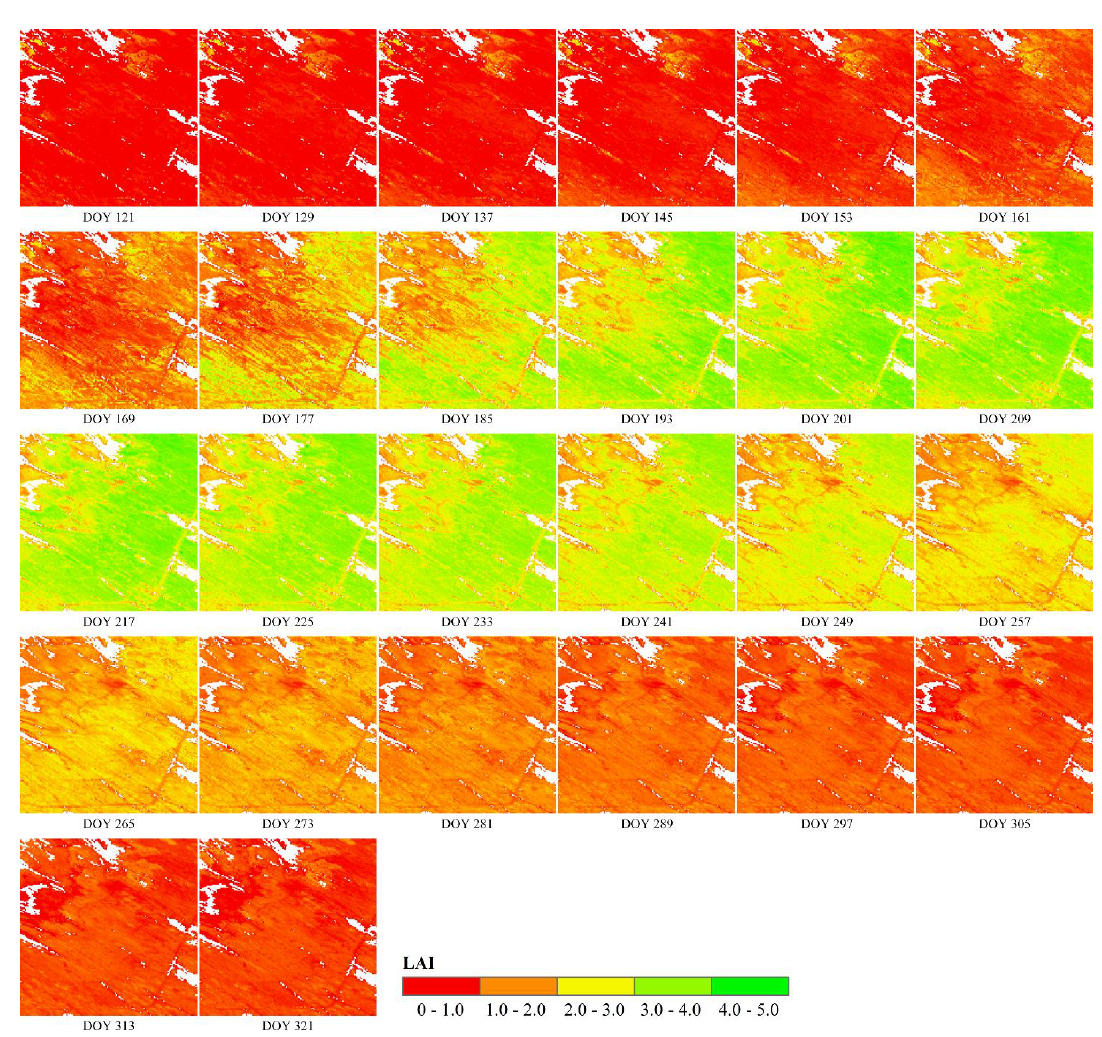
Figure 7. Maps of the estimated LAI at high spatiotemporal resolution (30-m and 8-day). The white areas represent non-vegetated cover types.